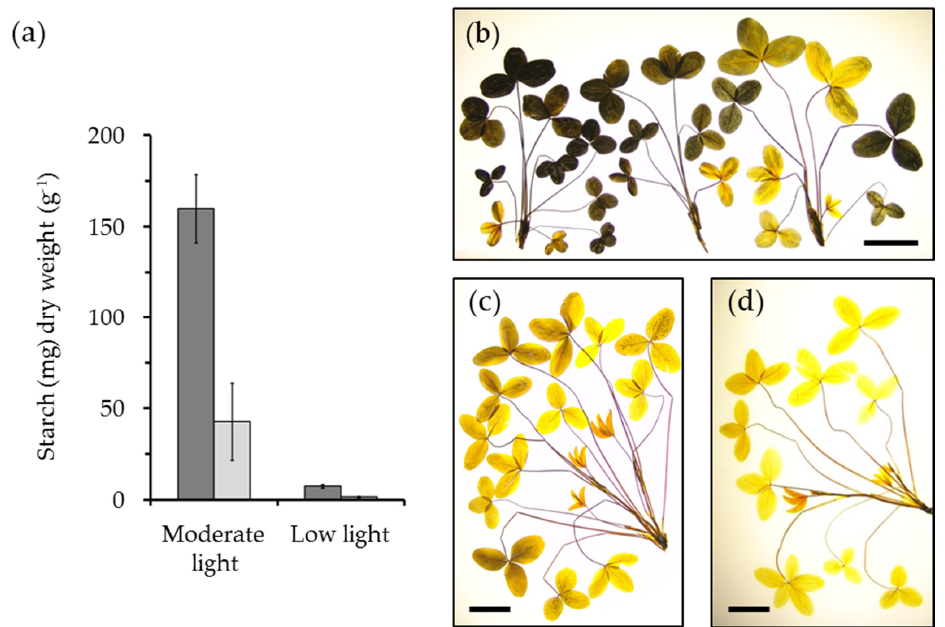
Figure 4. Starch concentration in red clover is dependent on the light intensity. ( a ) The starch concentration in TpDST34 harvested at the ED (dark ‐ gray bars), and at the EN (light ‐ gray bars). Plants of TpDST34 were grown under a moderate fluence rate of 250–350 μ mol m 2 s − 1 or a low fluence rate of 50–150 μ mol ∙ m 2 ∙ s − 1 . Other growth conditions were the same as described in Figure 3. Error bars indicate 95% confidence intervals ( N = 8); ( b – d ) Iodine staining of moderate light grown ED (left 2 plants) and EN (right) TpDIST34 , and low light ED (c) and EN (d) TpDIST34 . Details are described in Supplementary Methods.